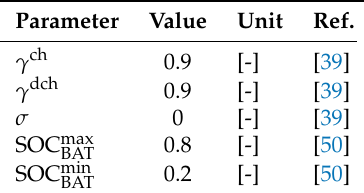
Table A5. Parameter data